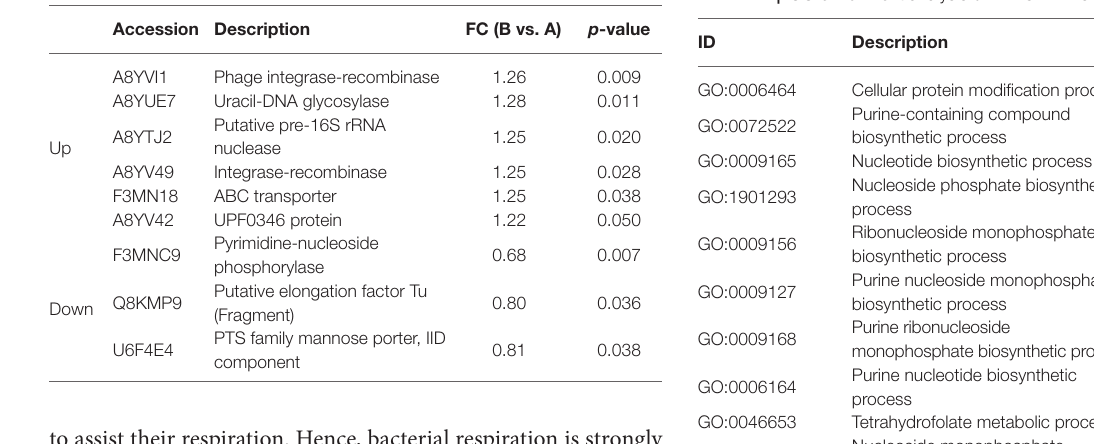
TABLE 3 | Regulation of DEPs in B vs. A.